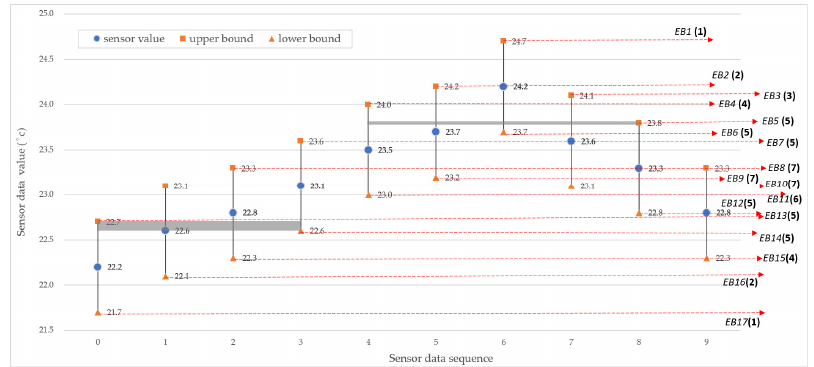
Figure 4. An example of EB-RLE and EB-HC under bounded error 0.5.